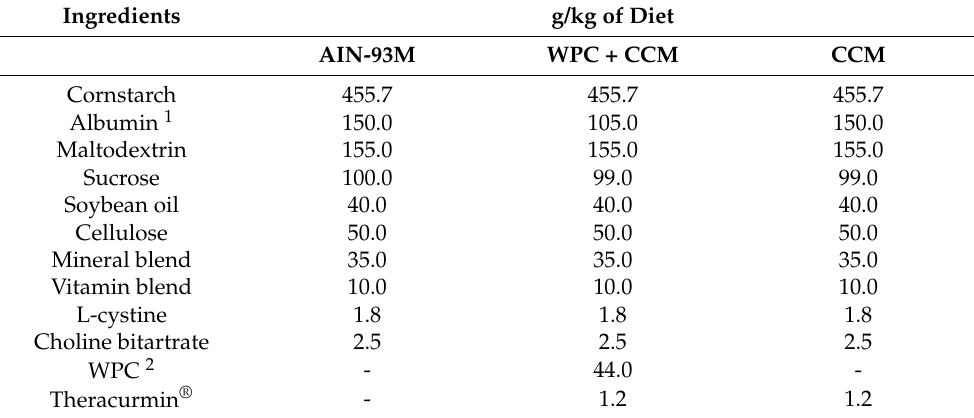
Table 1. Composition of experimental